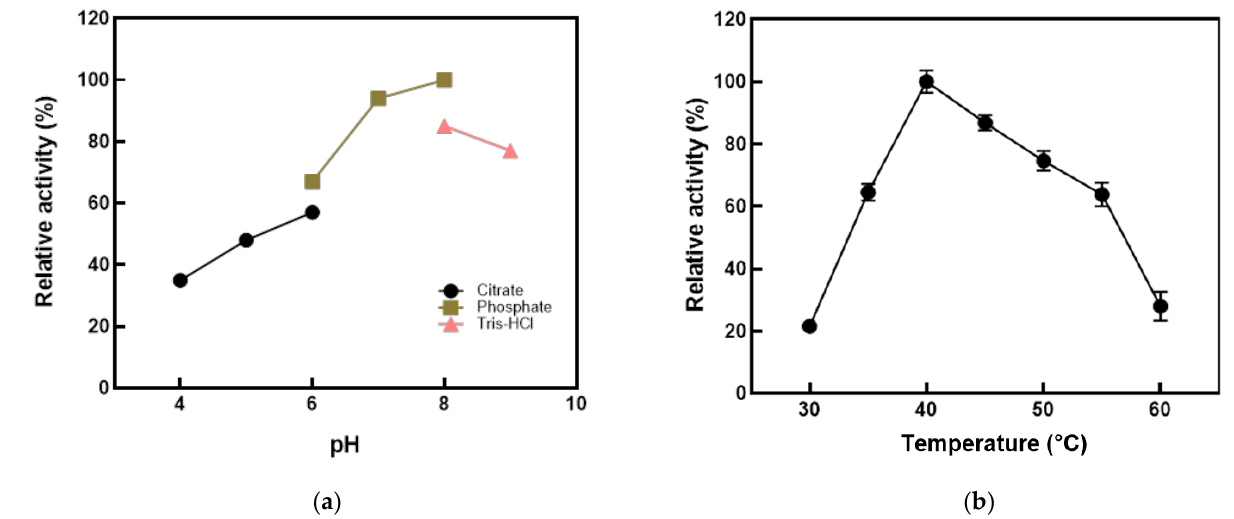
Figure 2. Effects of pH and temperature on the activity of L -arabinose isomerase from K. pneumoniae . ( a ) Effect of pH. The reactions were performed in 50 mM citrate (pH 4.0–6.0), phosphate (pH 6.0–8.0), and Tris-HCl (pH 8.0–9.0) buffers containing 50 mM D -galactose and 0.8 U/mL enzyme at 35 °C for 10 min. ( b ) Effect of temperature. The reactions were performed in 50 mM phosphate buffer (pH 8.0) containing 50 mM D -galactose and 0.8 U/mL enzyme at different temperatures, ranging from 30 °C to 60 °C for 10 min. Data represent the mean of values from three experiments, and error bars represent standard deviation.